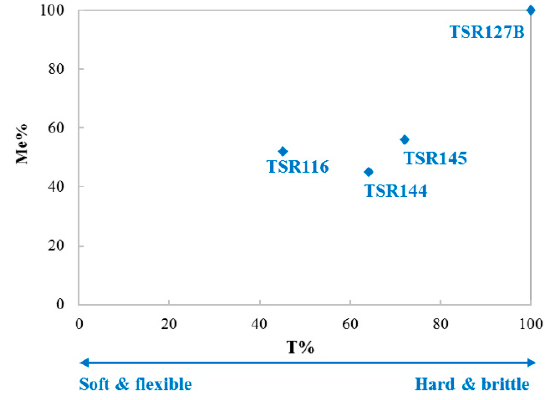
Figure 7. Properties of different pure silicone resins .